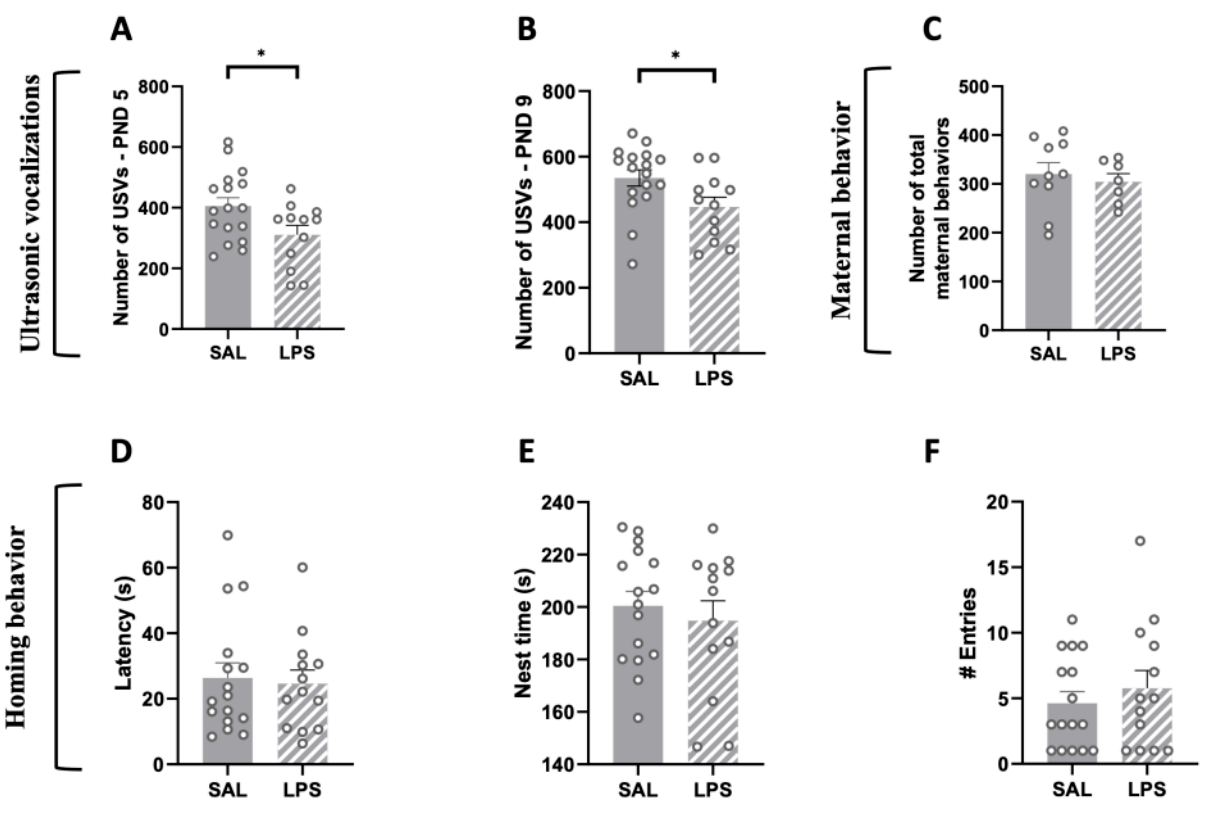
Figure 1. Impact of prenatal LPS exposure on maternal behavior, social communication and social discrimination in the infant rat offspring. LPS-exposed pups vocalized significantly less compared to SAL-exposed pups at both PNDs 5 ( A ) and 9 ( B ) (PND 5: SAL = 17, LPS = 12; PND 9: SAL = 17, LPS = 12). The altered USV profile displayed by LPS-exposed pups was not secondary to changes in maternal care ( C ) (Dams: SAL = 10, LPS = 7). LPS-exposed rats showed intact social discrimination abilities in the homing behavior task, as indicated by their latency to reach the nest arena ( D ), the total time spent in the nest zone ( E ) and the number of entries in the nest zone ( F ) (PND 13: SAL = 16; LPS = 13). Data represent mean ± S.E.M. * p < 0.05 vs. SAL (Student’s t -test).